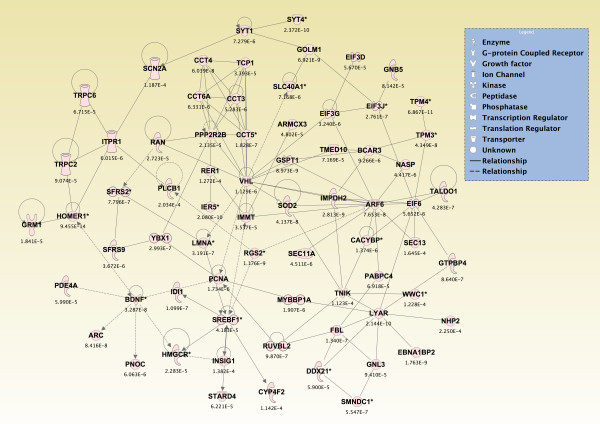
Seizure-induced alteration of lipid metabolism, small molecule biochemistry, and vitamin/mineral metabolism gene network.